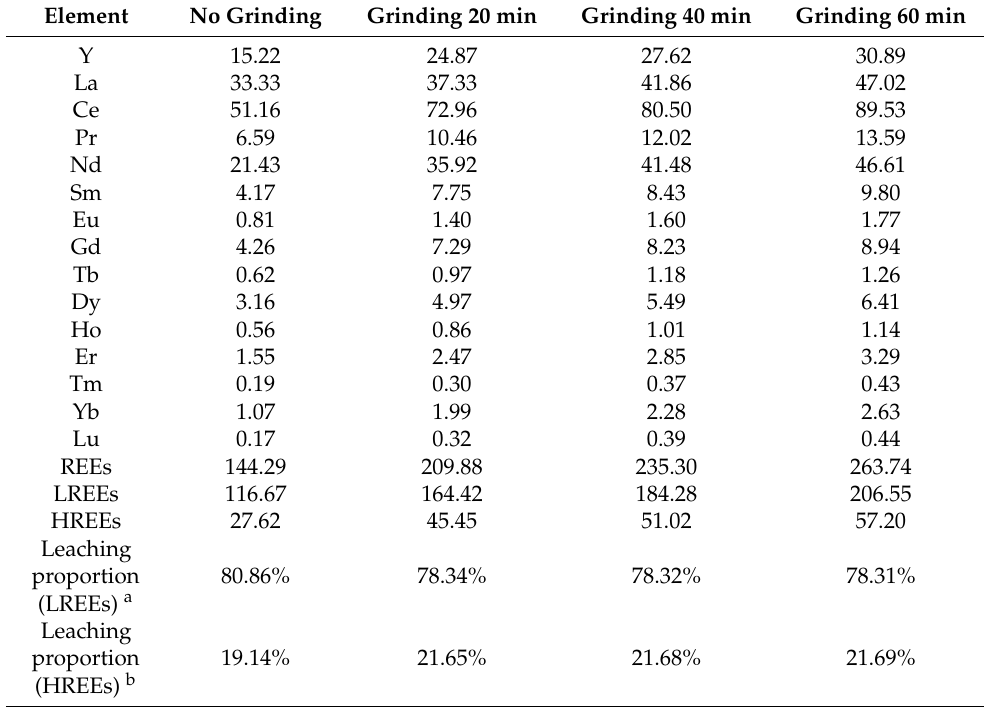
Table 5. Contents of the rare earth elements after leaching at different grinding times